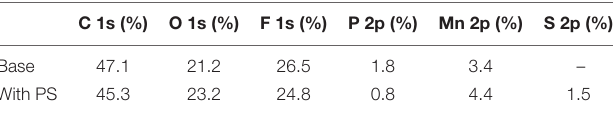
TABLE 4 | Element concentrations of the cycled cathodes using base electrolyte and PS-containing